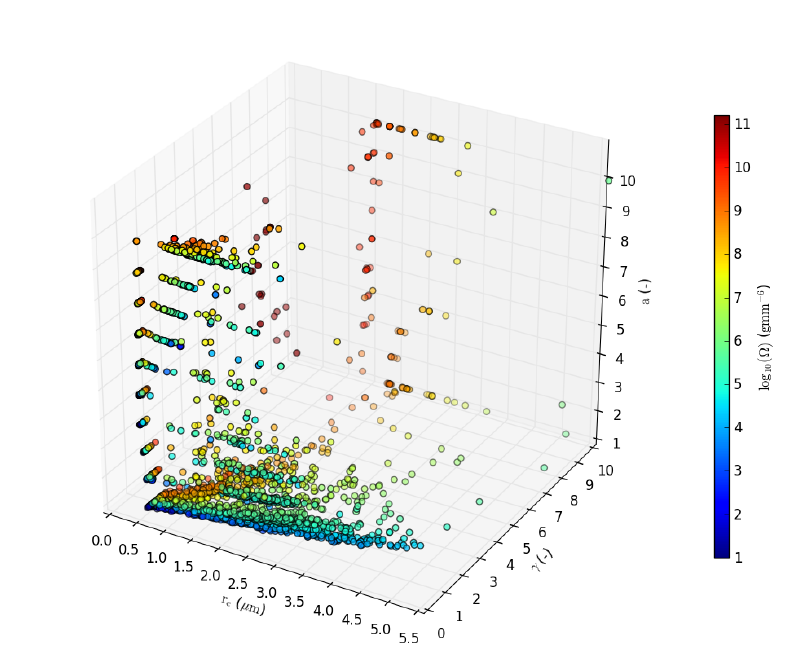
Figure 9. MGD parameter sets of Fog Events 1, 2 and 3 colored after Ω .